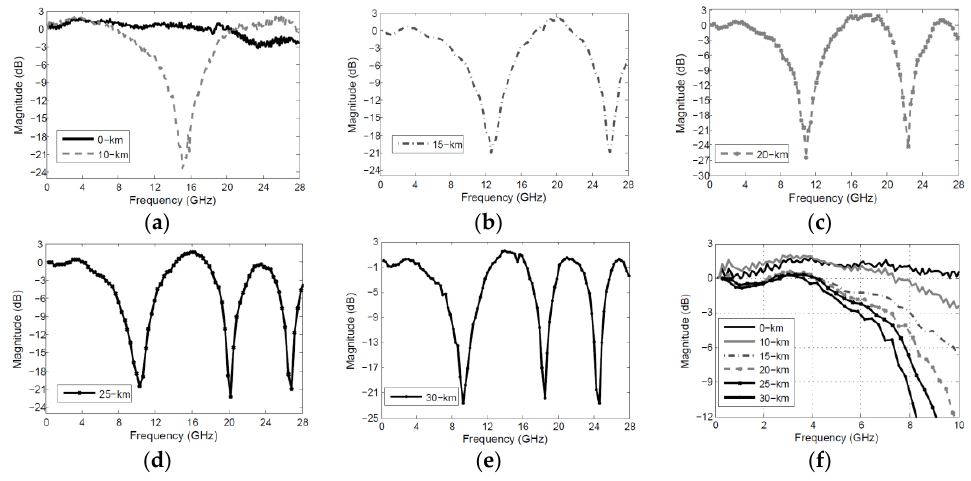
Figure 4. Eye-diagrams before and after FIR for back-to-back, 10-km, 15-km, 20-km, 25-km, and 30-km for the experimental setup of Figure 1a.